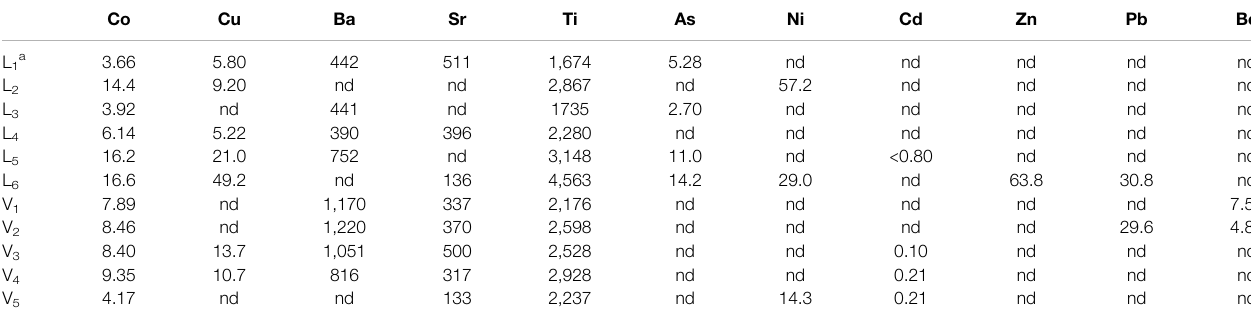
TABLE 1 | Content of element in mineral resources in Leskovac (L) and Vranje (V) Neogene basin (ppm). Co Cu Ba Sr Ti As